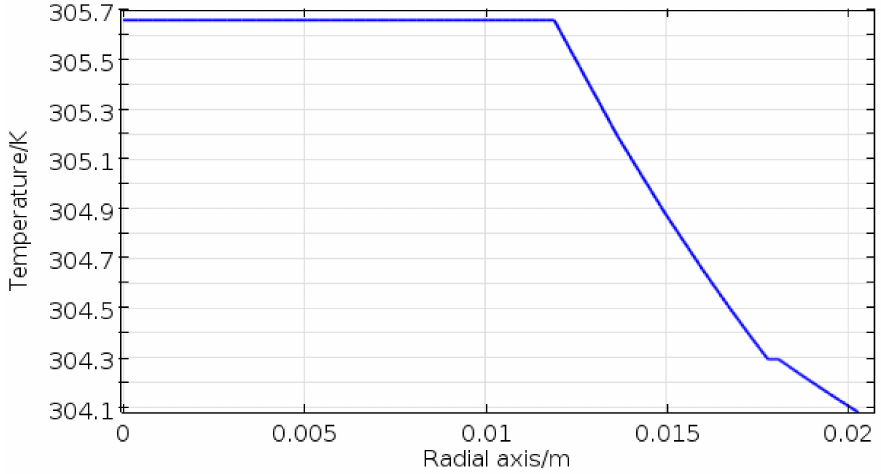
Figure 5. Temperature curve along radial direction of